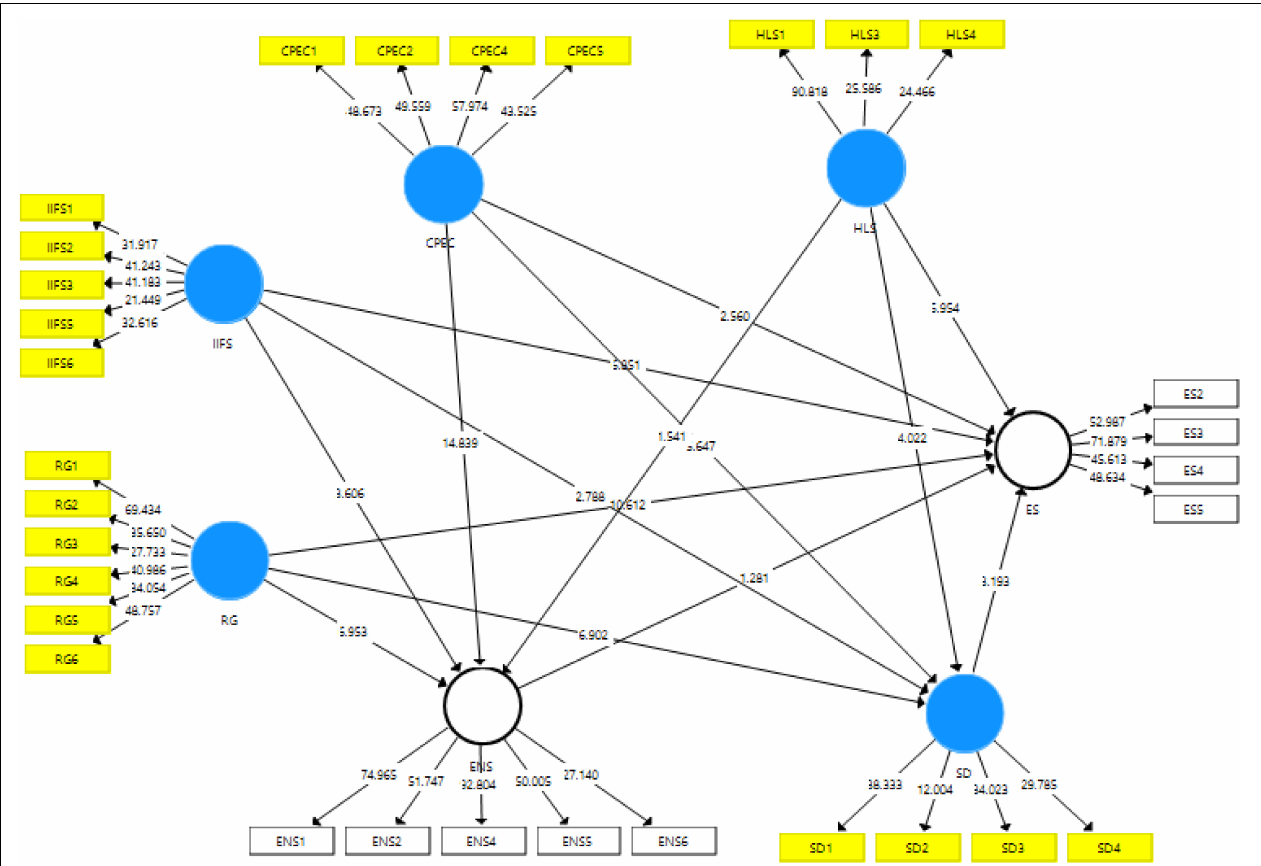
FIGURE 3 | Structural model